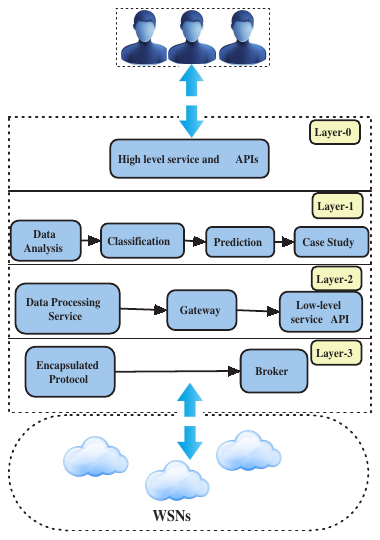
Figure 2. Proposed multi-agent